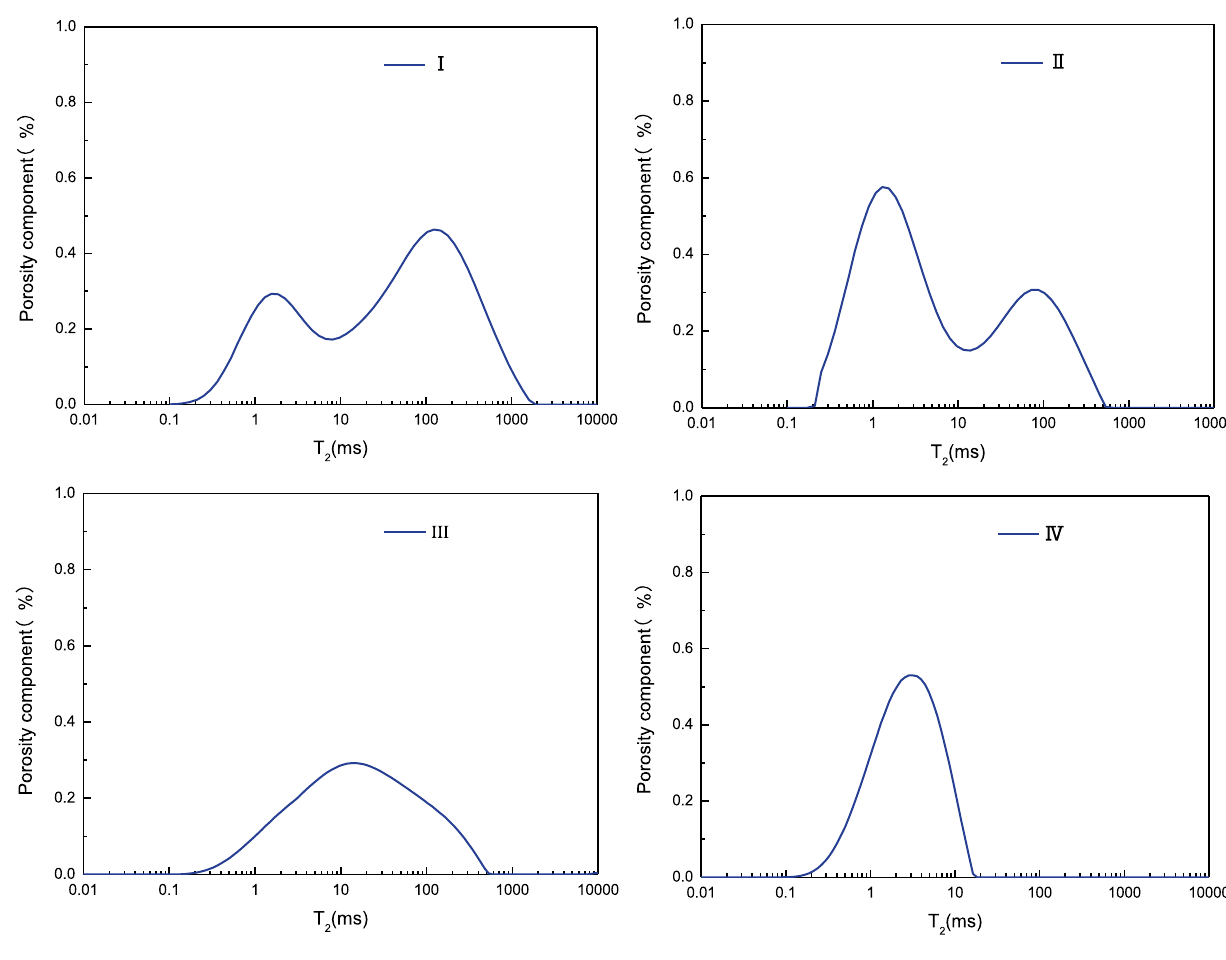
Fig. 15 Inversion of nuclear magnetic decay spectra with different pore structures Table 2 T 2 parameter table of rock structure spectrum with different pore structures Pore structure